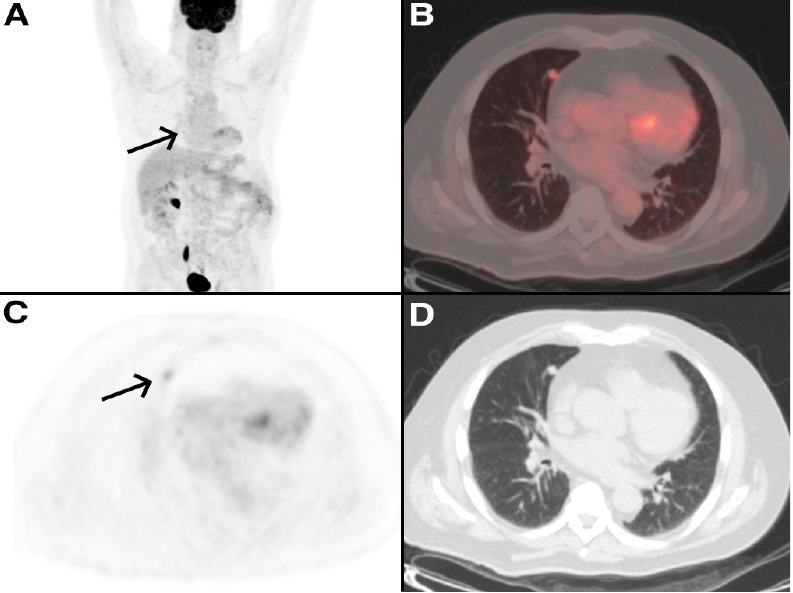
Figure 3. A 72-year-old man treated 3 years earlier with total nephrectomy of the left kidney for RCC, referred to medical consultation for dyspnea. A ceCT scan was performed showing a lung nodule in the right middle lobe. [ 18 F]FDG PET/CT was also performed and showed a mild uptake of the tracer in the lung nodule (SUVmax 2.8, arrows). Five months later, he underwent wedge re- section with histological examination of the surgical specimens, which confirmed that the lung nod- ule was a metastasis from the RCC. ( A ) Maximum Intensity Projection (MIP) image of [ 18 F]FDG PET/CT ( B – D ) PET/CT fusion image, PET and CT images of [ 18 F]FDG PET/CT.